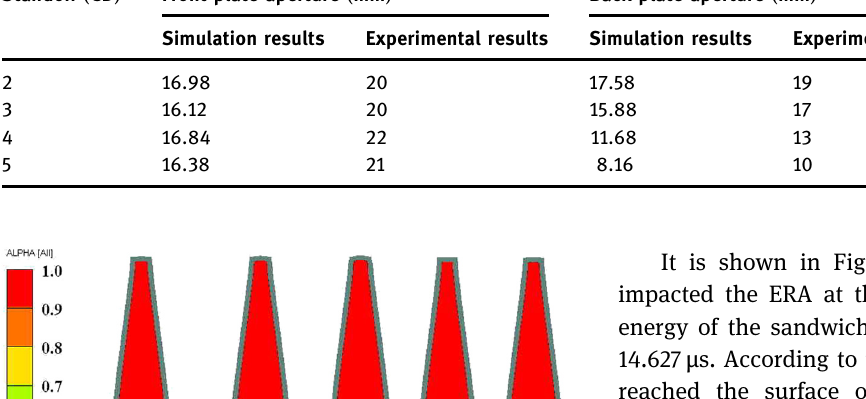
Table 7: Damage aperture parameters of PTFE jet to ERA front and back plates at di ff erent stando ff s Stando ff ( CD ) Front plate aperture ( mm )